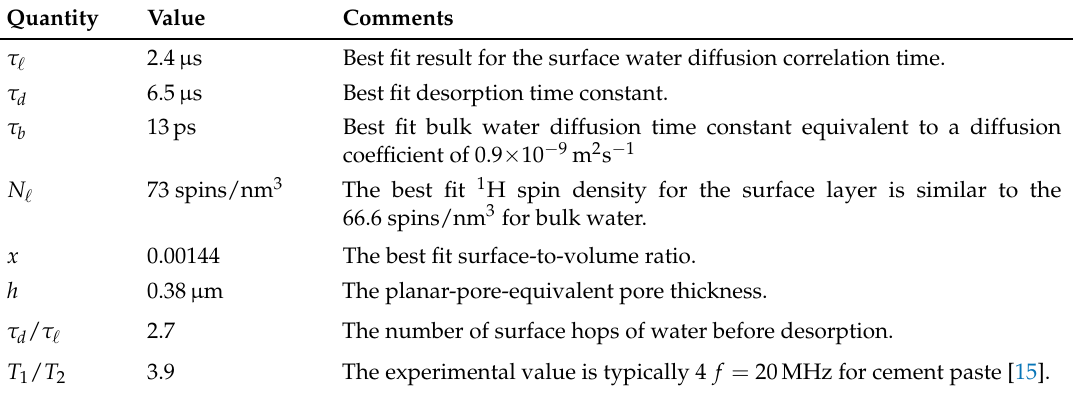
Table 3. Results of a fit of the 3 τ model to an FFC-NMR dispersion for a plaster paste from Korb [5] using